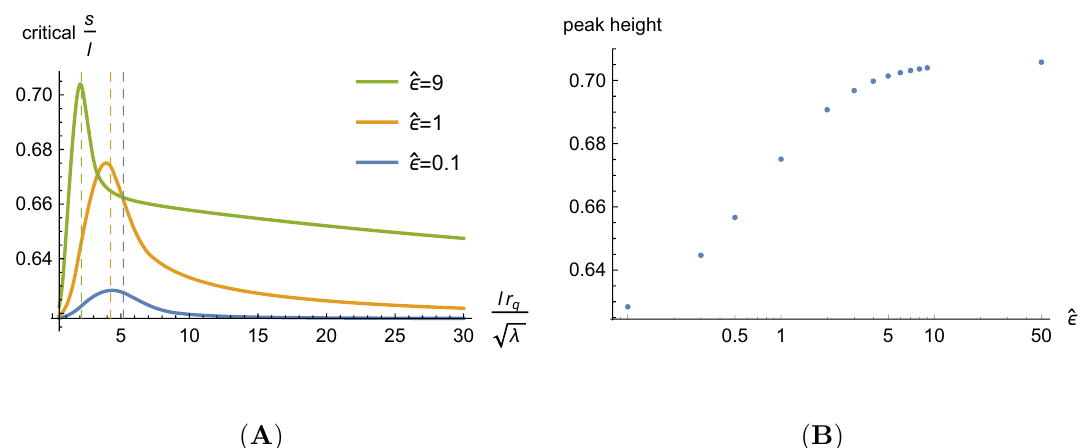
Figure 5 . ( A ) Numerical analysis of the critical value of s=l ( s = strip separation, l = strip width) at which the mutual information transition occurs for varying numbers of (cid:13)avors: (3 = 4)( N f =N ) (cid:21) = ^ (cid:15) = 0 : 1 ; 1 ; 9. As N f increases, the peak deviation from the conformal value of s=l grows, and occurs further in the UV (smaller strip widths l ). The vertical dashed lines are l q r q = width of the strip whose bulk minimal surface just touches the cavity for each ^ (cid:15) . ( B ) Peak deviation of the critical s=l as a function of the number of (cid:13)avors. The numerical evidence con(cid:12)rms that in the absence of (cid:13)avors (^ (cid:15) ! 0) we return to the conformal result s=l = 1 =’ where ’ is the golden ratio, and suggests that in the limit of many (cid:13)avors (^ (cid:15) ! 1 ) the deviation from the conformal value